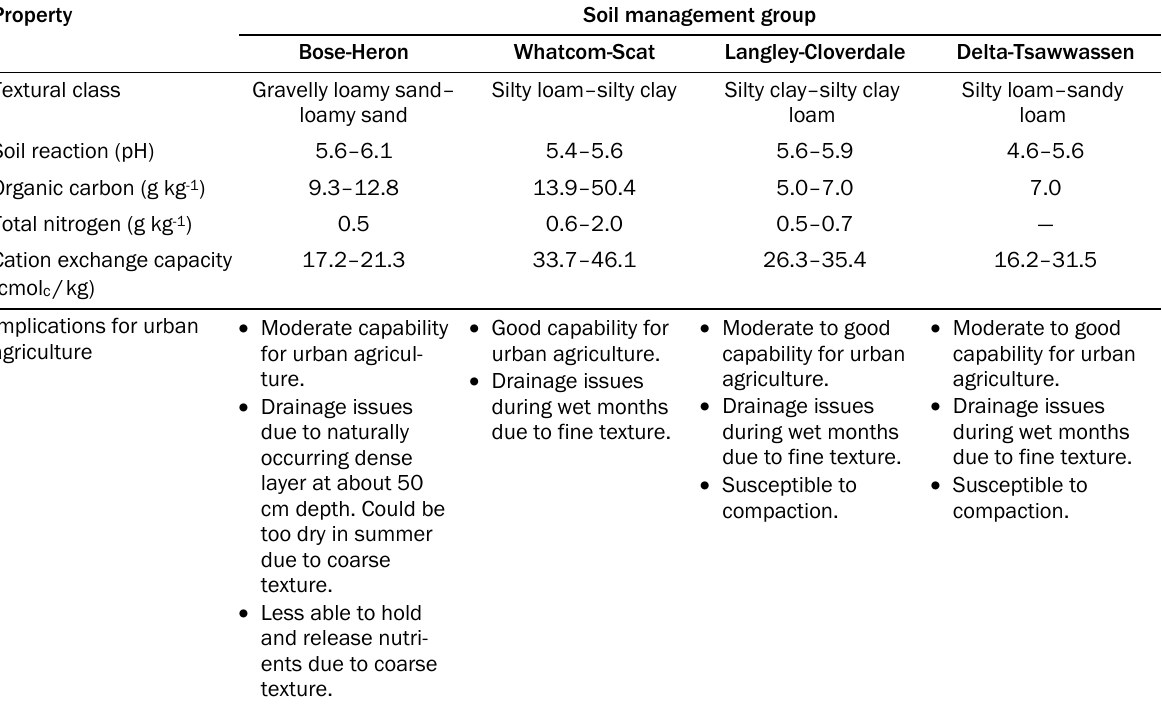
Table 3. Properties of the Top Mineral Horizon of the Four Soil Management Groups Encountered within the City of Vancouver, British